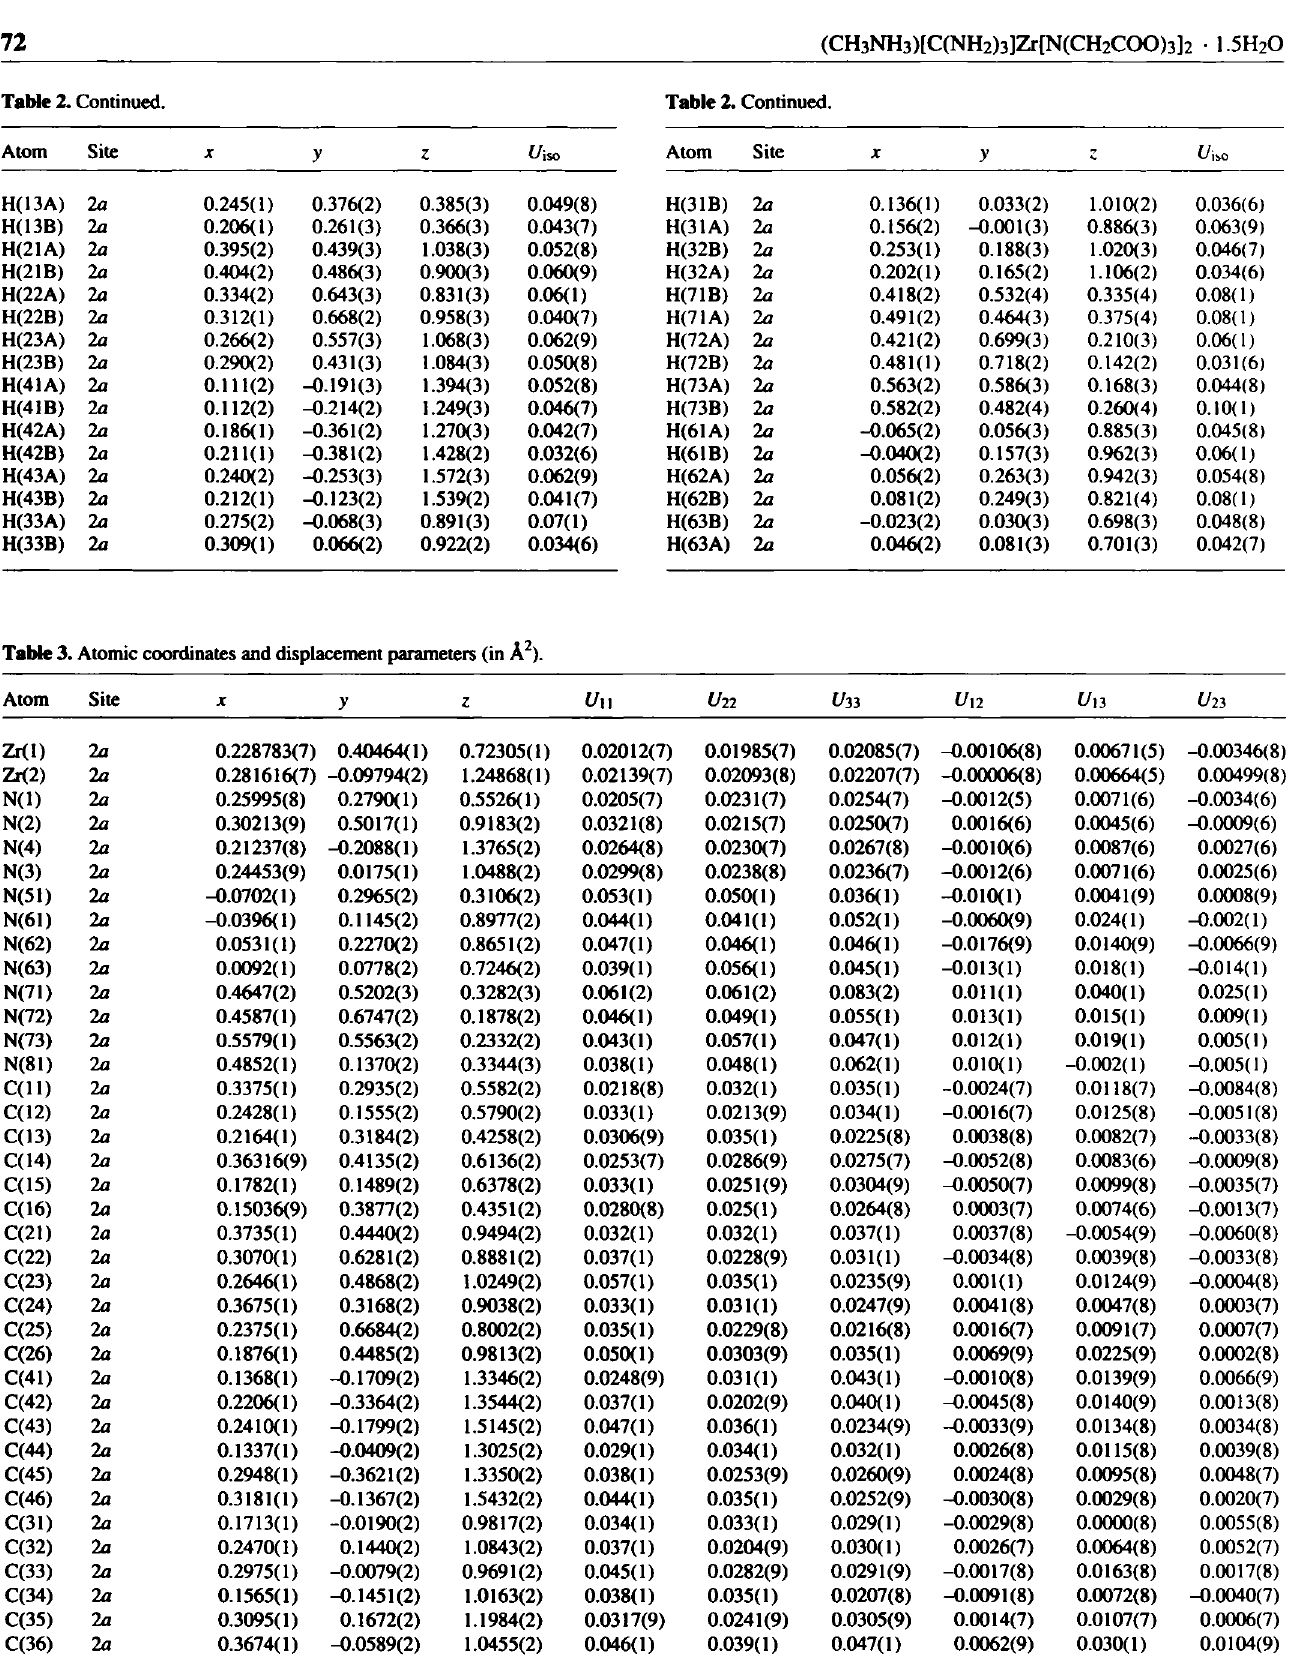
Table 3. Atomic coordinates and displacement parameters (in Â 2